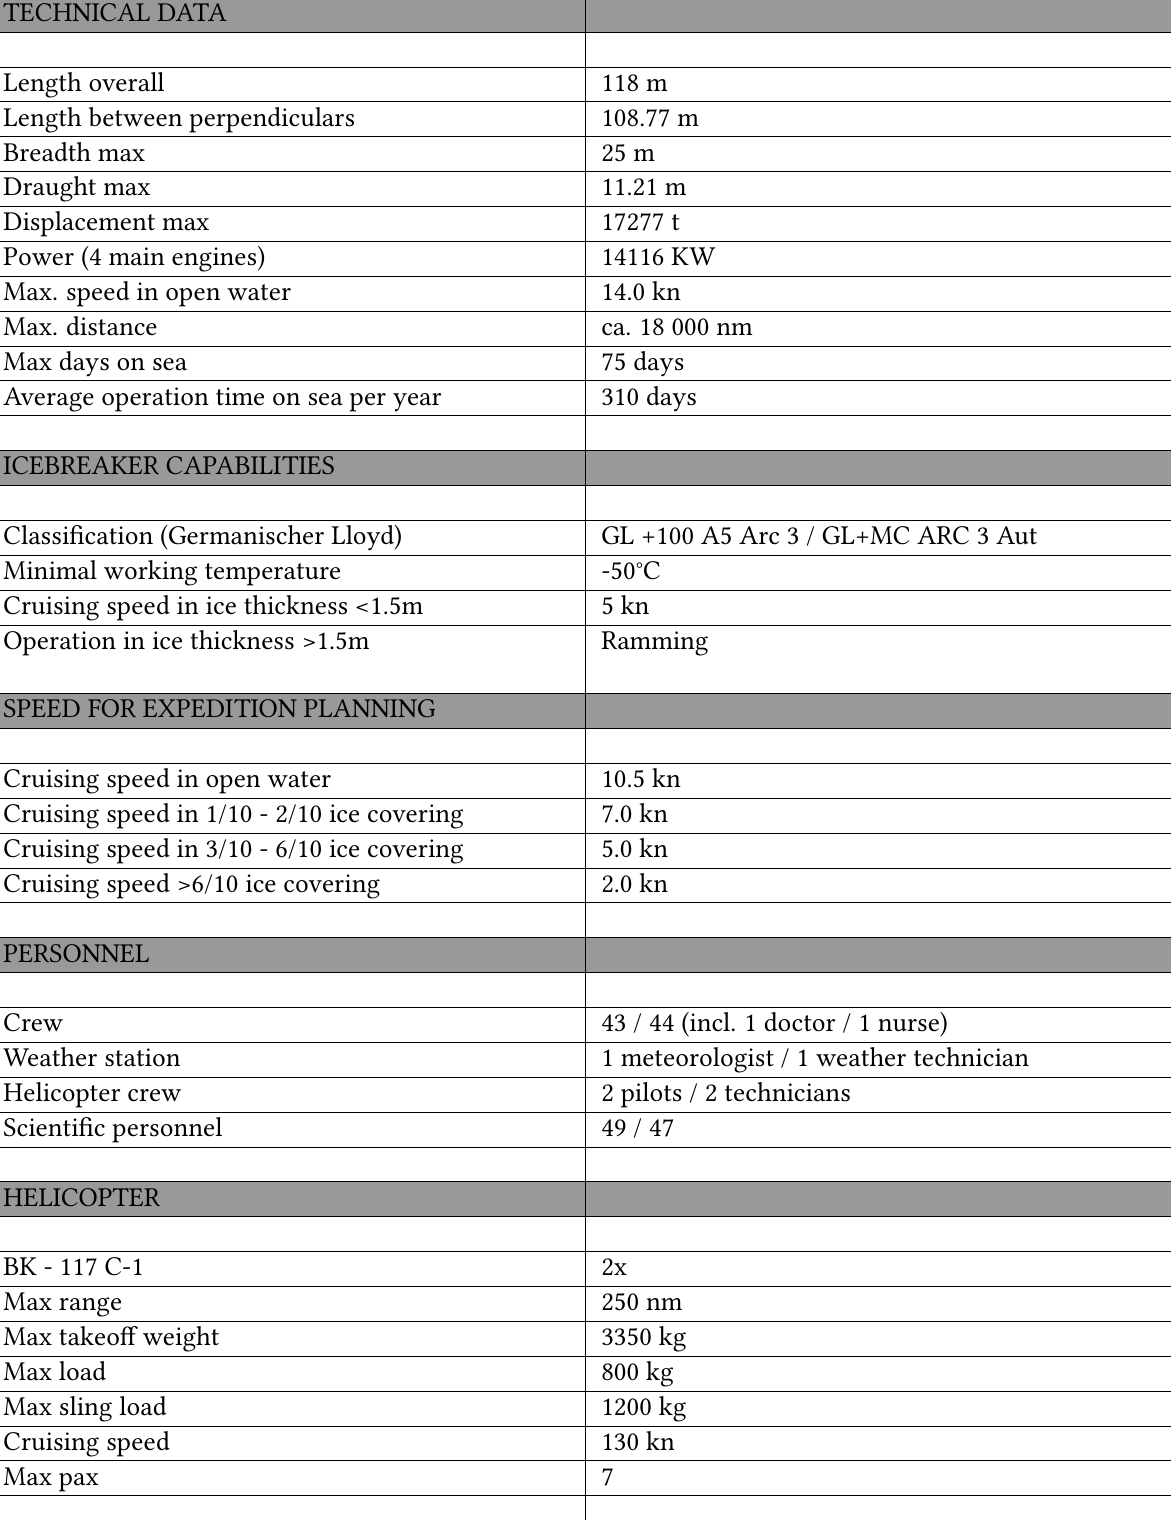
Table 1: Technical